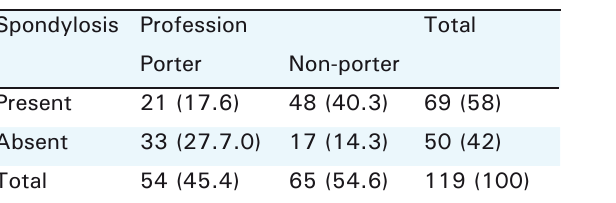
table 3. Frequencies and percentage of spondylosis in porters and non-porters.